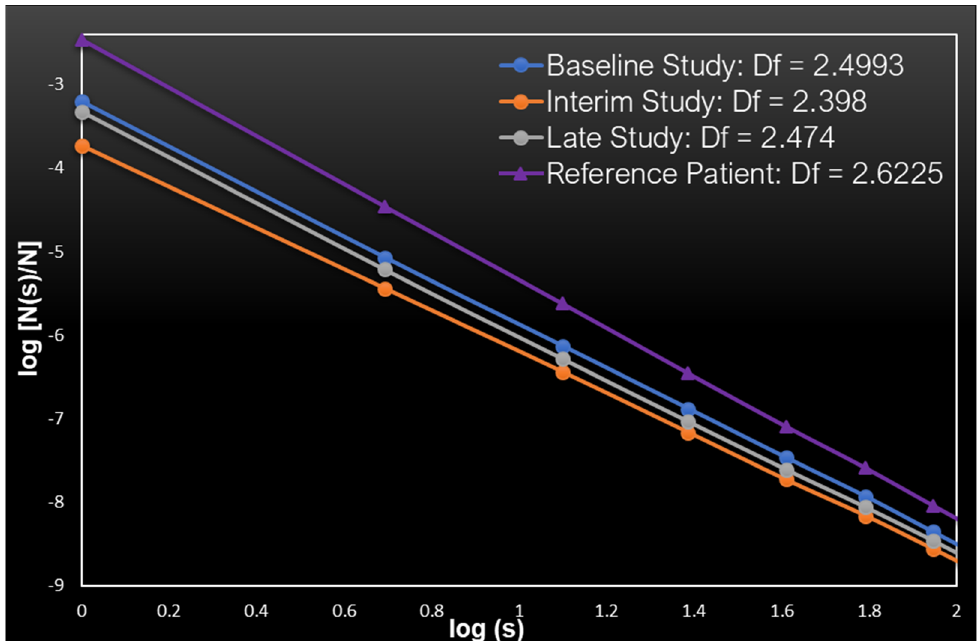
Figure A2. The normalized number of boxes N(s)/N which contain the tracer as a function of the box size s in a double logarithmic scale for patient P11, whose clinical diagnosis was PMD. The blue line corresponds to the baseline study of patient P11, the orange line to the interim study and the gray line to the final study of the same patient. For comparison, the purple line representing healthy control H3, is also depicted.